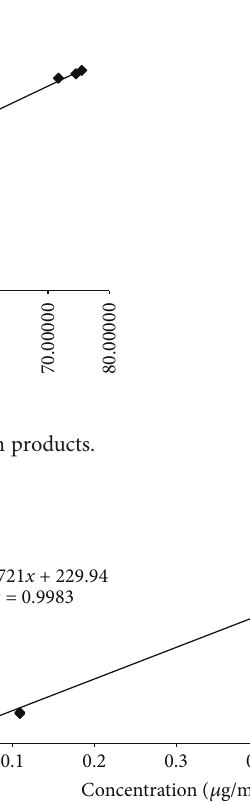
Figure 11: LOD and LOQ for ketorolac in